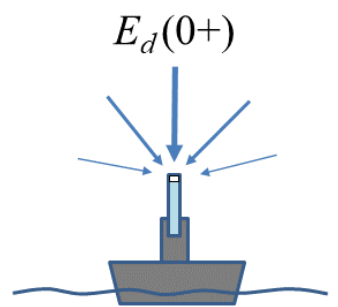
Figure 3. Schematic (not drawn to scale) of (shipborne) direct above-water measurement of 𝐸 𝑑0+ with an irradiance sensor (pale blue with flat white cosine collector).